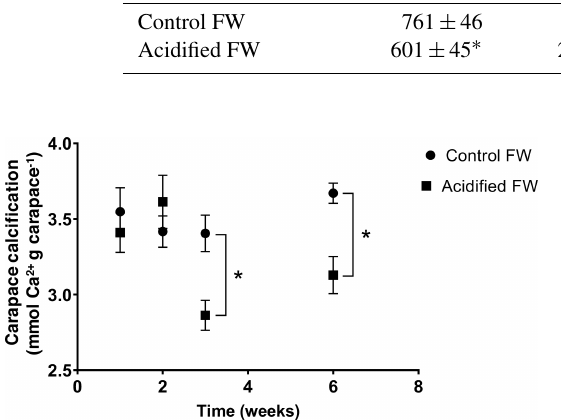
Figure 4. Changes in carapace calcium content of juvenile Chinese mitten crabs, Eriocheir sinensis , over a 6-week exposure to control (pH 7.4, 1389µatm p CO 2 ) or CO 2 -acidified (pH 6.8, 4634µatm p CO 2 ) freshwater. Data are presented as mean ± SEM ( N = 6–12). Statistical significance was assessed by two-way ANOVA followed by a post hoc Tukey HSD test, with ∗ indicating significant differ- ence between control and acidified FW crabs for each respective